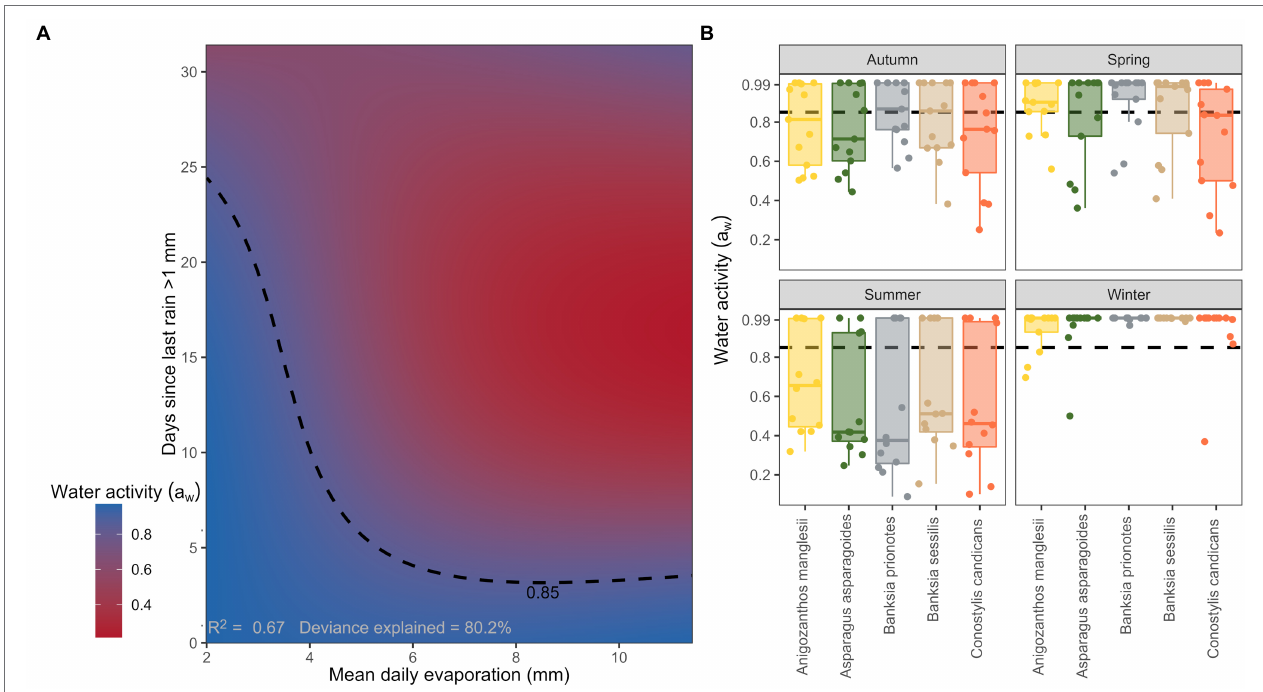
FIGURE 3 | (A) Modelled interactive relationships between seed water activity for seeds within in the soil seed bank, mean daily evaporation, and days since last rain >1 mm. Dashed contour line indicates the threshold water activity of 0.85 a w . (B) Patterns of water activity for each individual species for the year of 2017 stratified by season. Dashed line indicates the hydration threshold where seeds are >0.85 a w